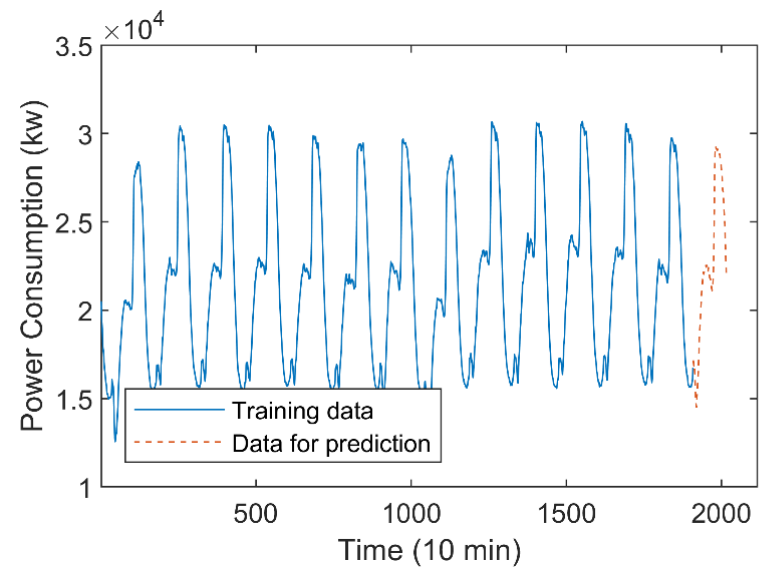
Figure 11. Time series of average power consumption in Tetuan. Table 2. Comparison of the prediction indexes of electricity consumption in